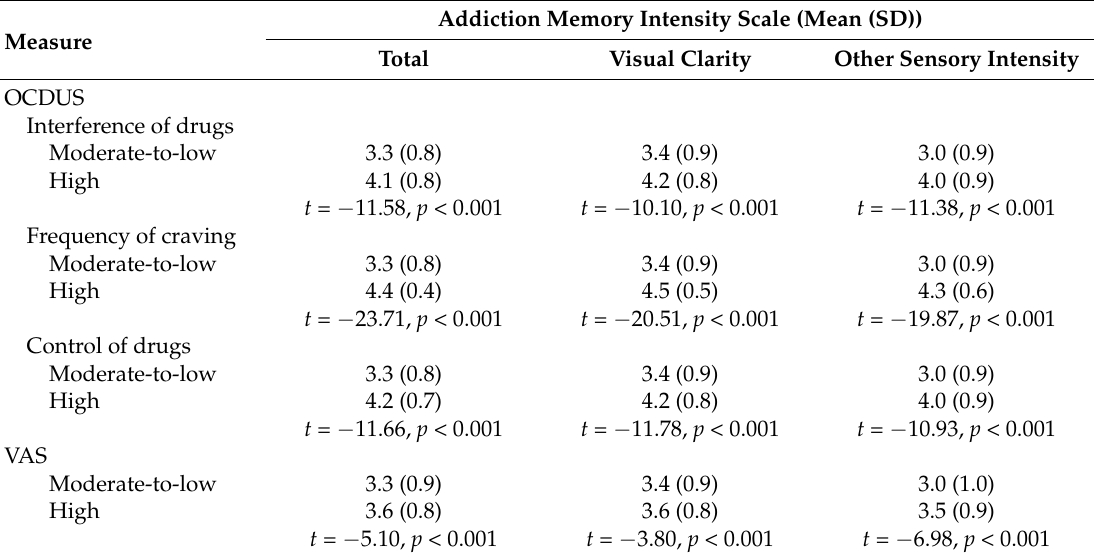
Table 6. Discriminant validity of the Addiction Memory Intensity Scale ( n =